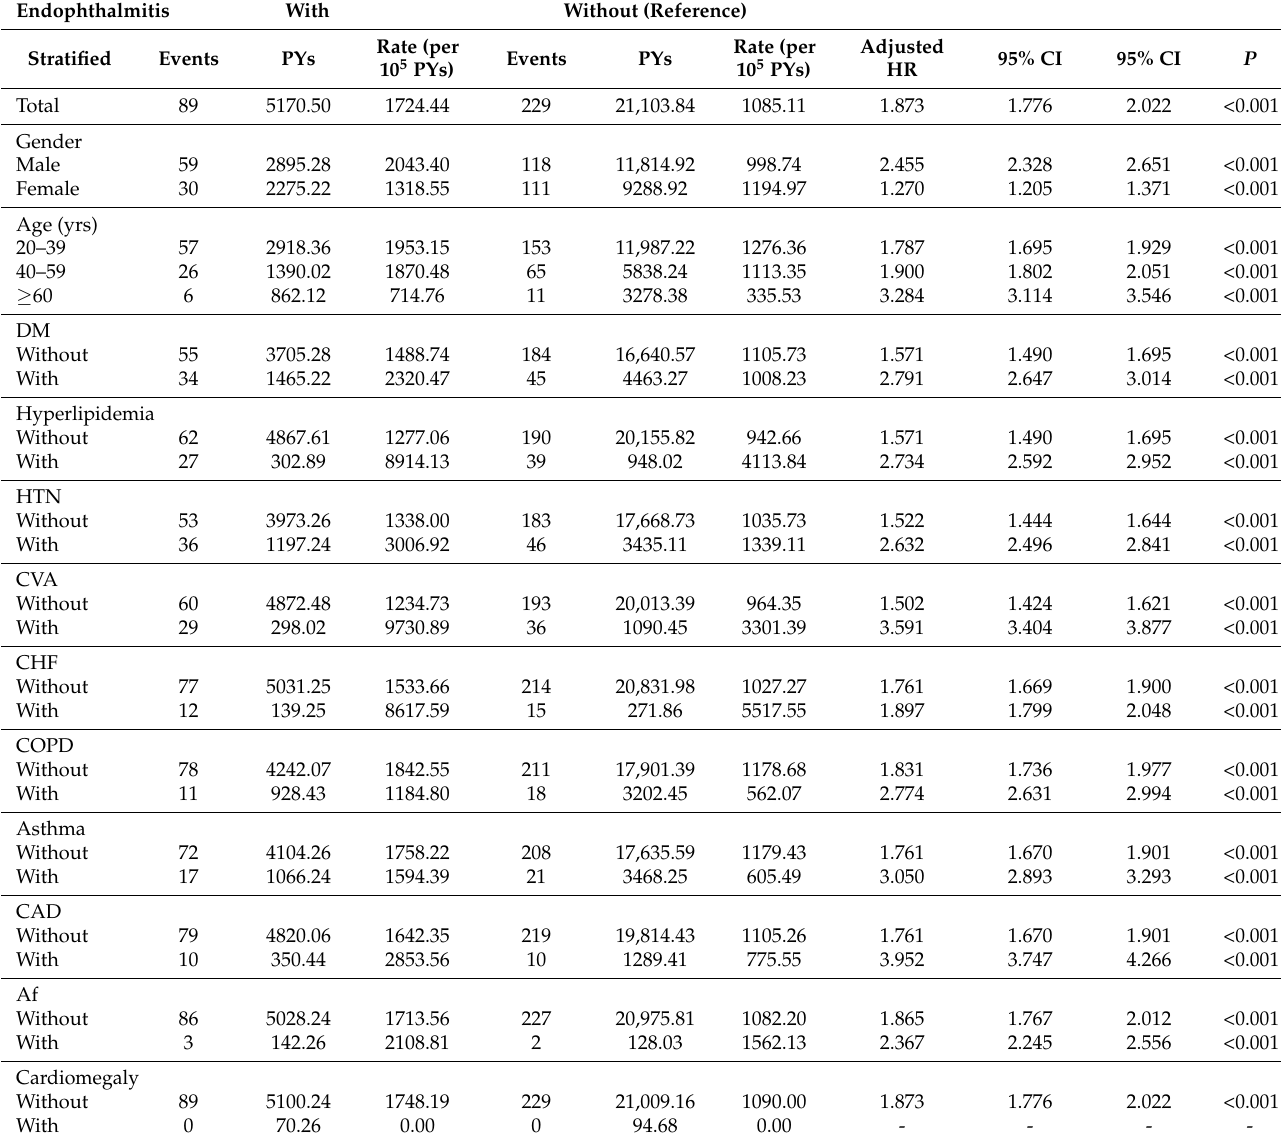
Table 4. Factors of stroke stratified by study variable using Cox regression analysis.